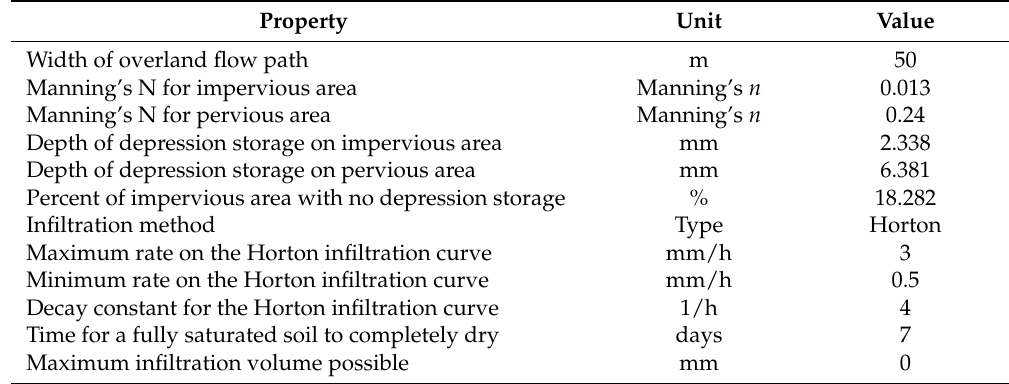
Table 2. Properties of sub-catchment in the Storm Water Management Model (SWMM) input file S i